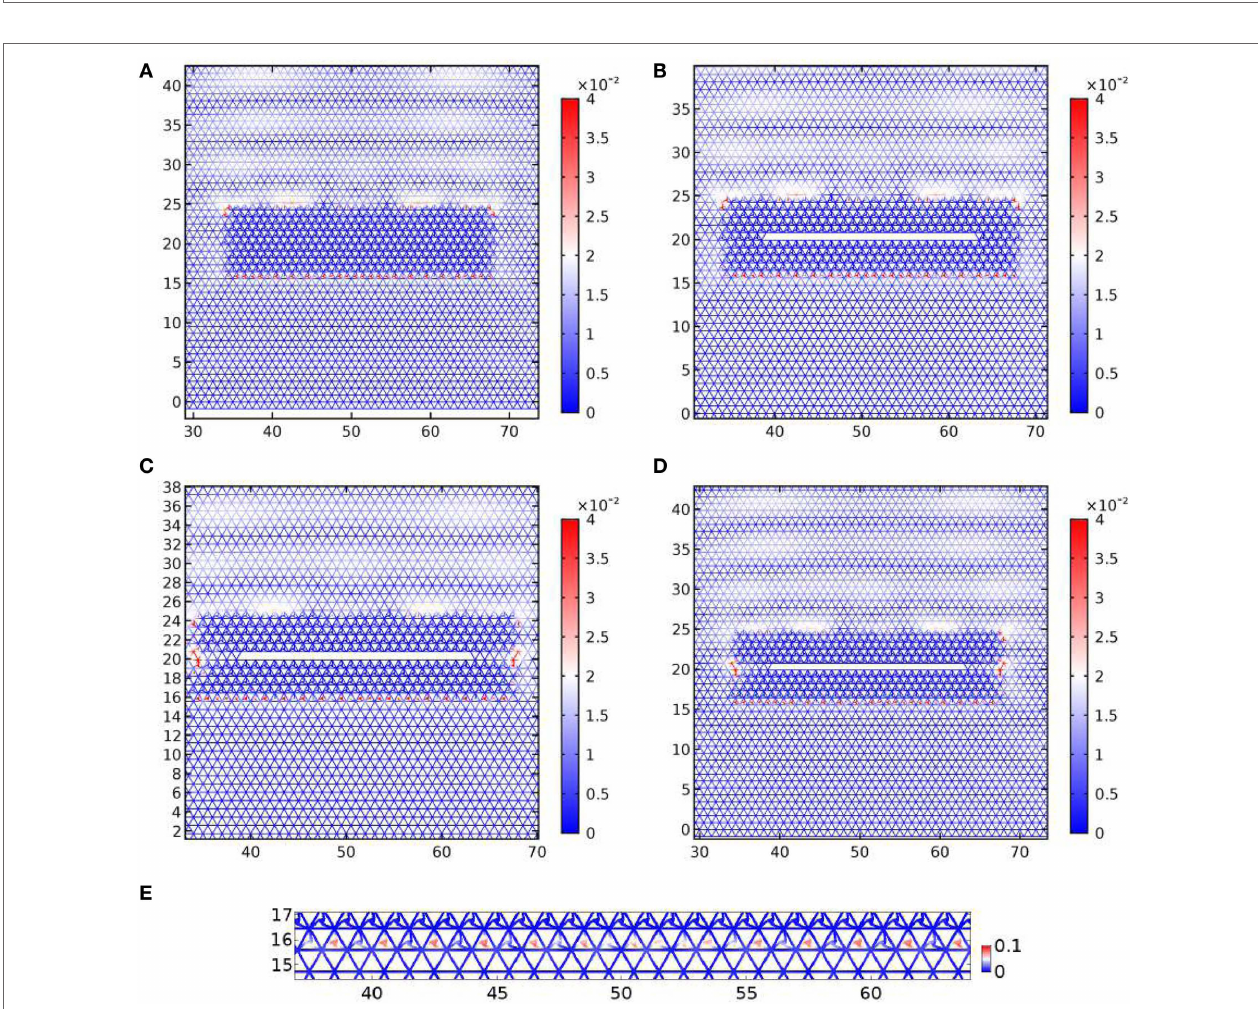
FIGURE 10 | The harmonic response of a cluster of resonators to a shear plane wave of frequency ω = 2.4rad/s inside the stop band for the TLR. Panels (A,B) are without and with a crack. Panels (C,D) include a line of resonators missing along the extension of the crack. In panel (C) , the tilting angle is homogeneous, whereas in panel (D) , the resonators are tilted through opposite angles. Panel (E) is a detail of the lower boundary of the cluster in panel (A) showing an edge wave. The lattice parameters are as in Figure 8 .